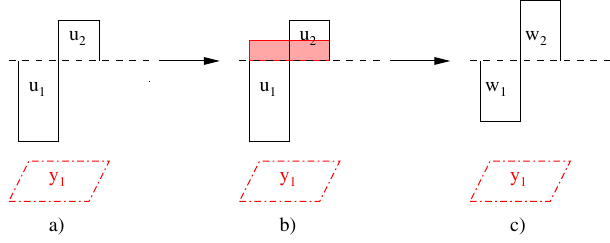
FIG. 1. (Color) Influence of a superconductive closed loop in- stalled at the undulator surface. The loop covers a single un- dulator period. Without the induced current in the loop (a) the magnetic flux in the two half periods is different. For the sake of simplicity it is assumed that the flux has a rectangular shape.